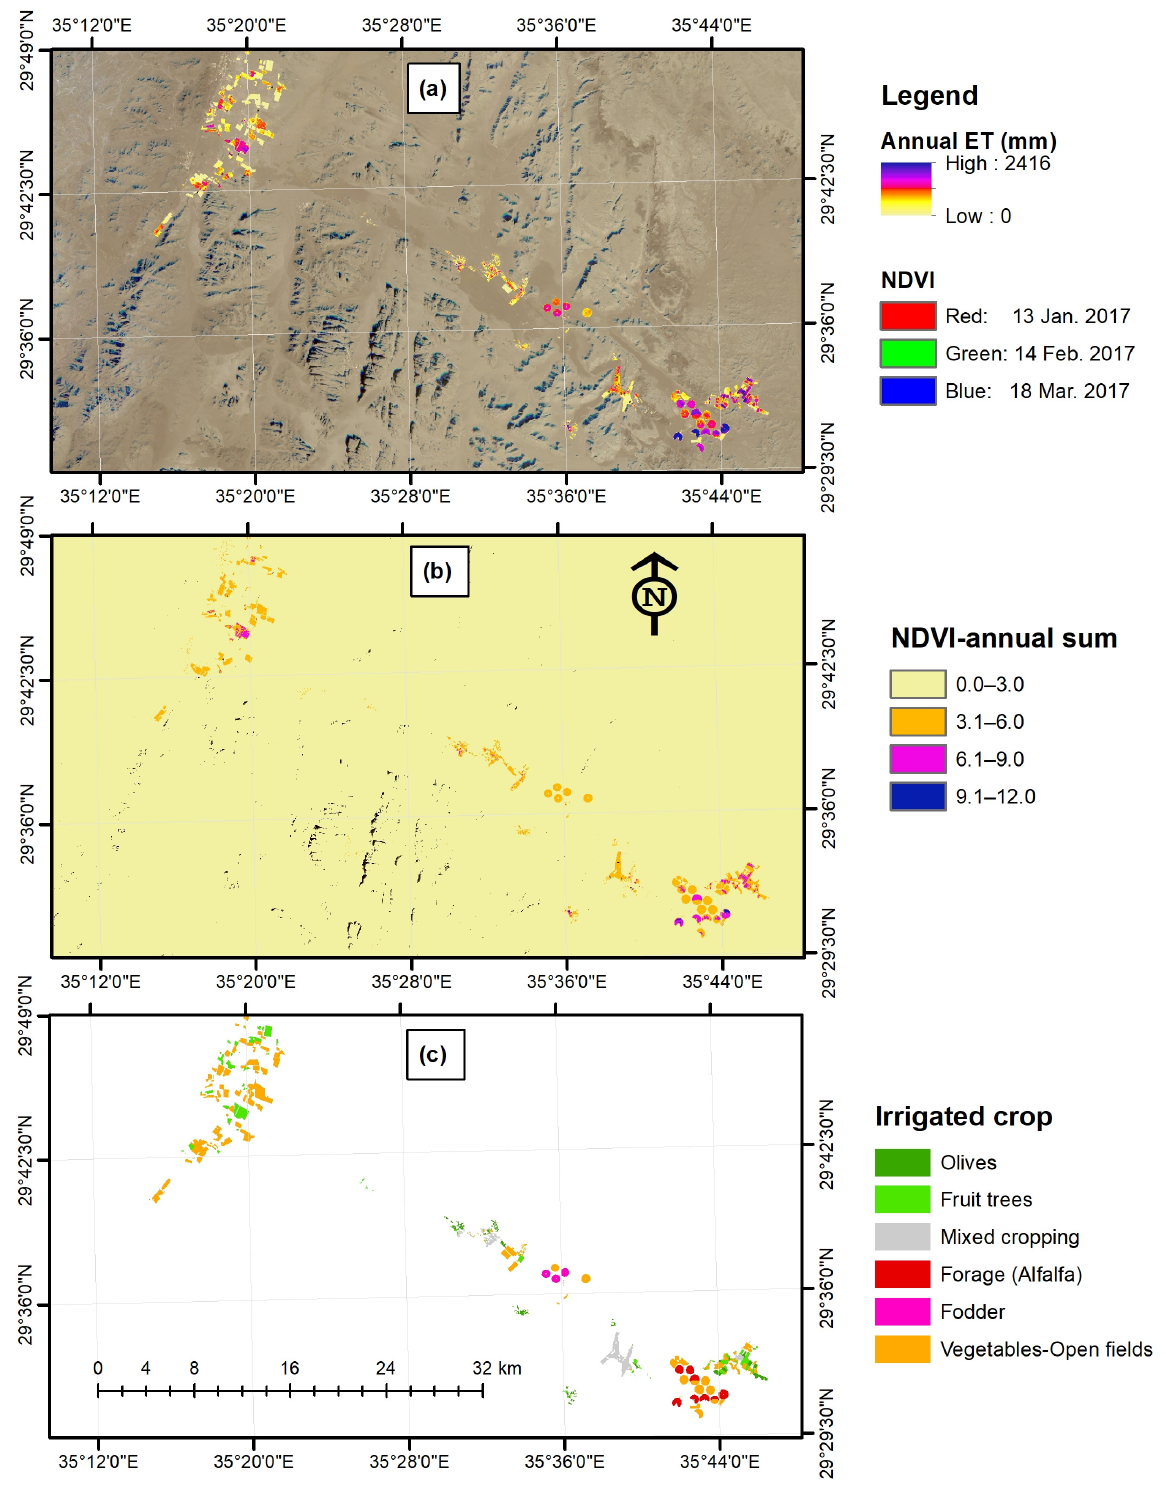
Figure 8. Mapping of irrigated crops in the desert of Badia in the Quwayrah-Disi area. ( a ) SEBAL- ET map displayed over the multi-temporal NDVI layers of 2017; ( b ) Classification of crops based on the annual sum of NDVI; ( c ) Final map of irrigated crops merging maps of ET and classified annual NDVI.